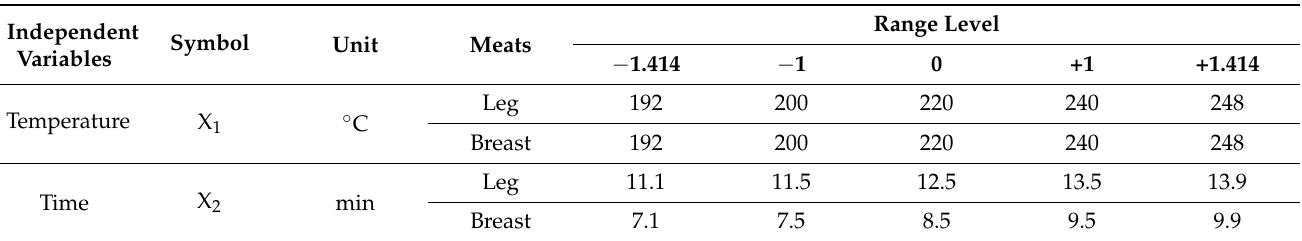
Table 1. Independent variables, codes, and actual levels for optimizing the superheated treatment of chicken products. Independent